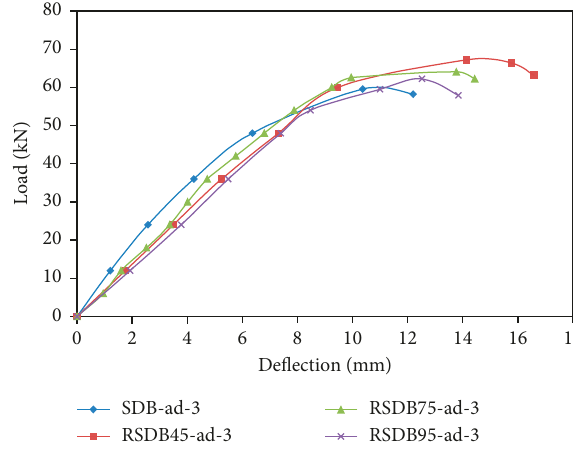
Figure 4: Load-deflection plot of shear-designed beams tested at a / d ratio